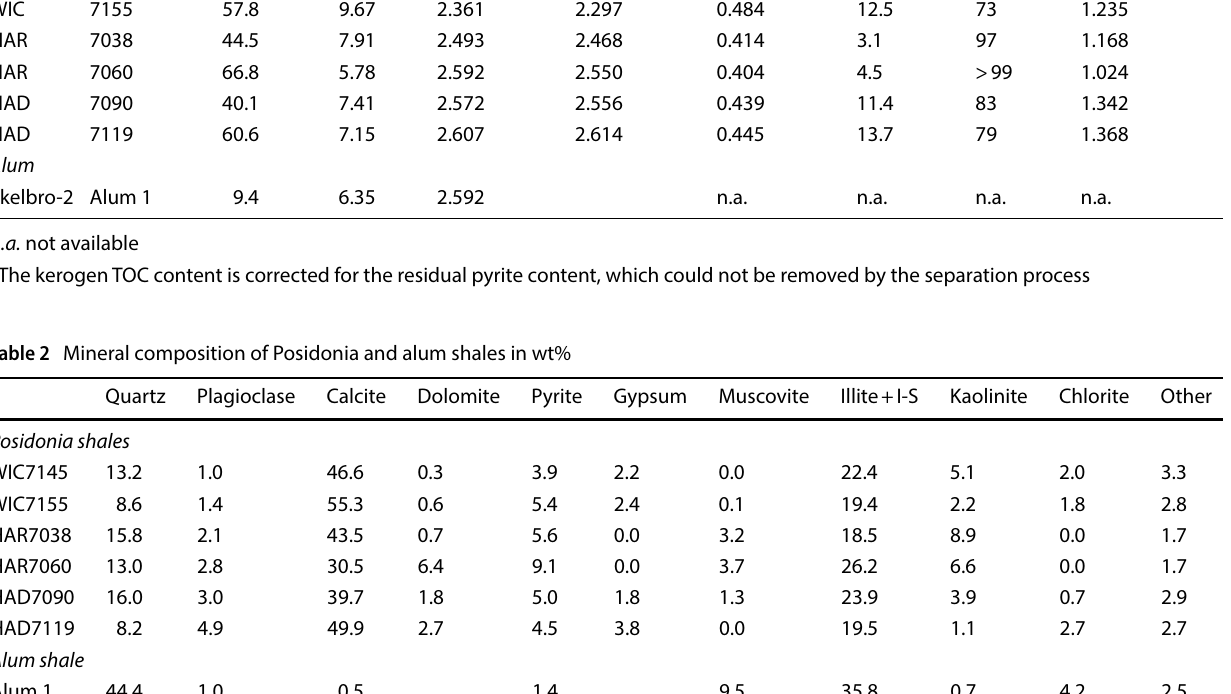
Other minerals includes Feldspar, Siderite, Anatase, Marcasite, Aragonite and Dickite